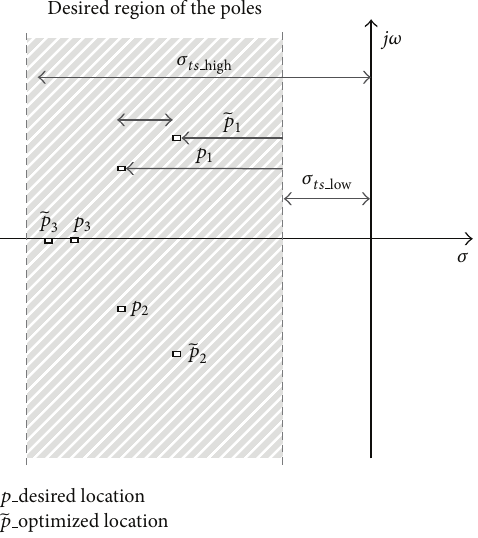
Figure 2: Settling-time objective function with settling-time and 𝜎 𝑡𝑠 boundaries 𝜎 𝑡𝑠 low high